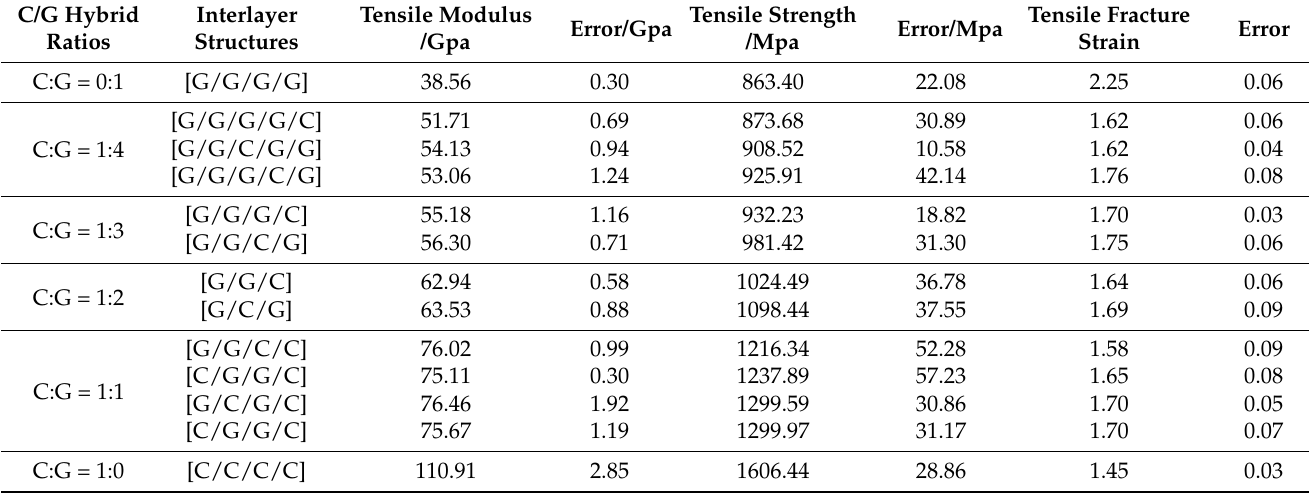
Figure 3. The testing sample. Table 6. The testing results of interlayer hybrid composites.